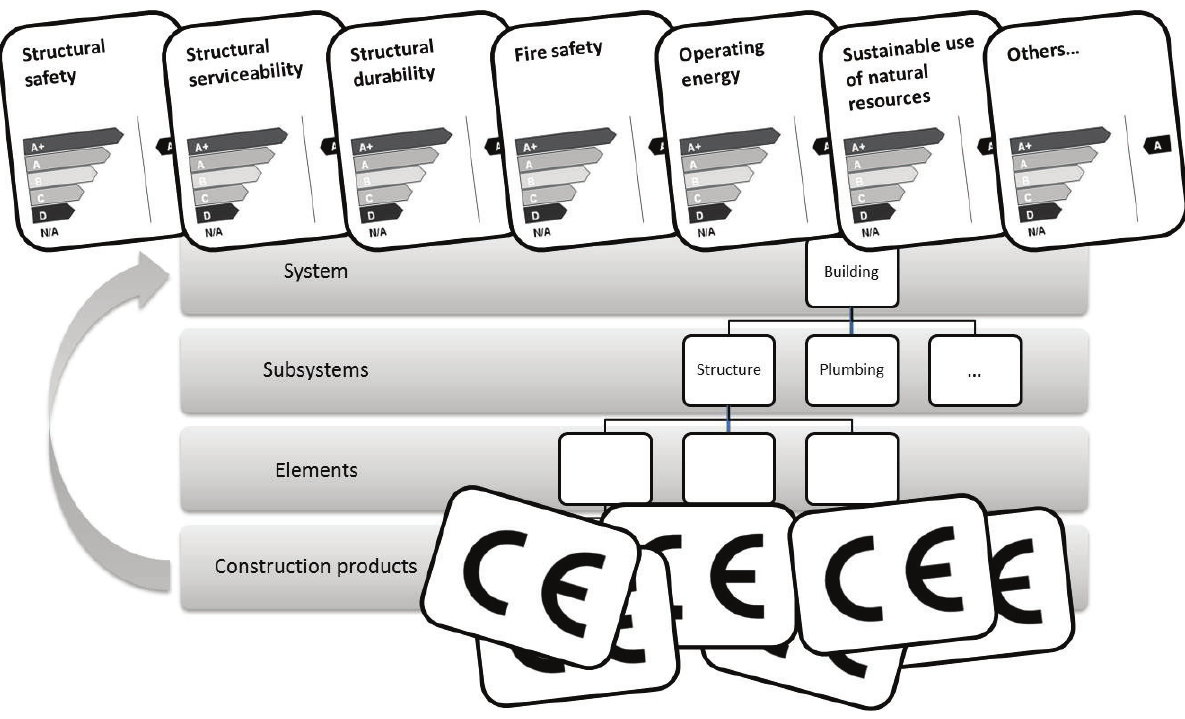
Fig. 4. Outreach of the proposed